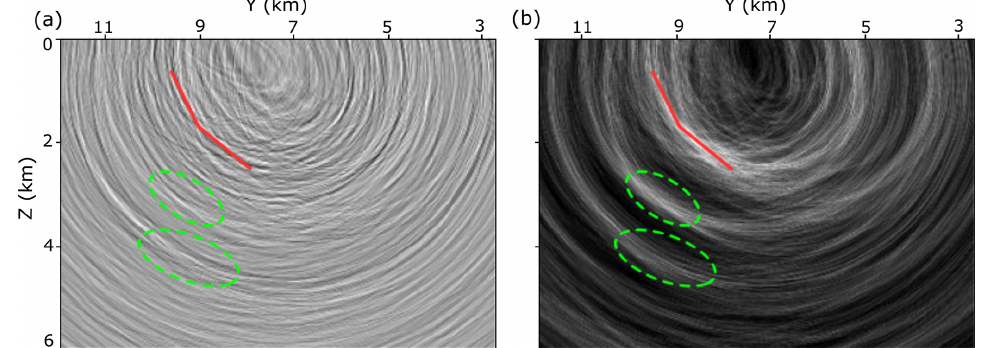
Figure 8. Zoomed-in illustration of the vertical slices through the phase-consistent image (a) and absolute values image (b) shown in Fig. 7. The solid red line shows the imaged part of the Roter Kamm fault, and the dashed green ellipses refer to the reflectors B and D in Figs. 12 and 13.